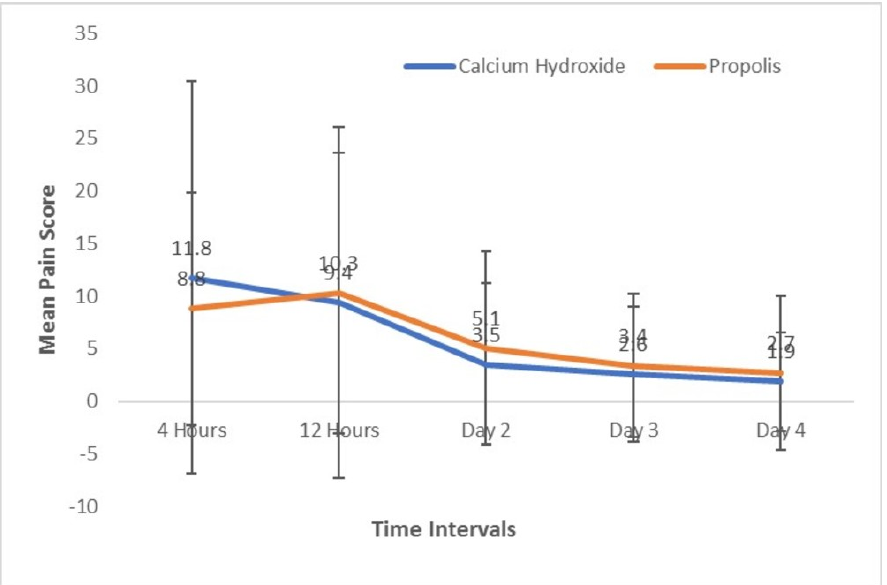
Figure 3. Pain score trend according to time .